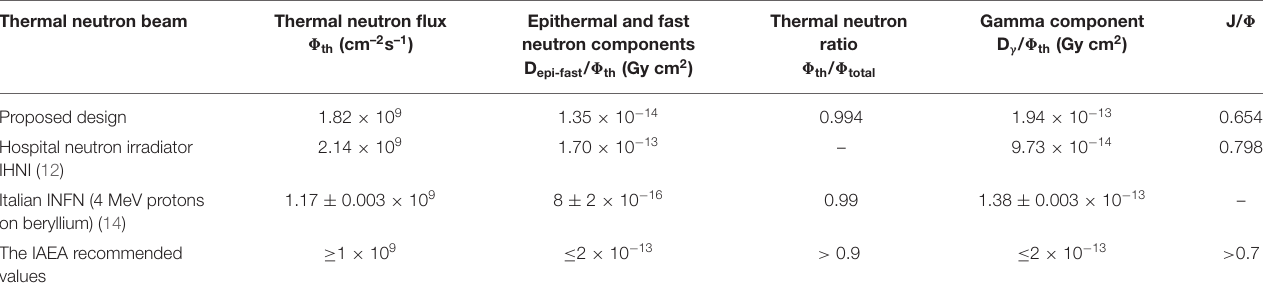
TABLE 2 | Thermal neutron beam parameters of proposed design and other designs in the world.